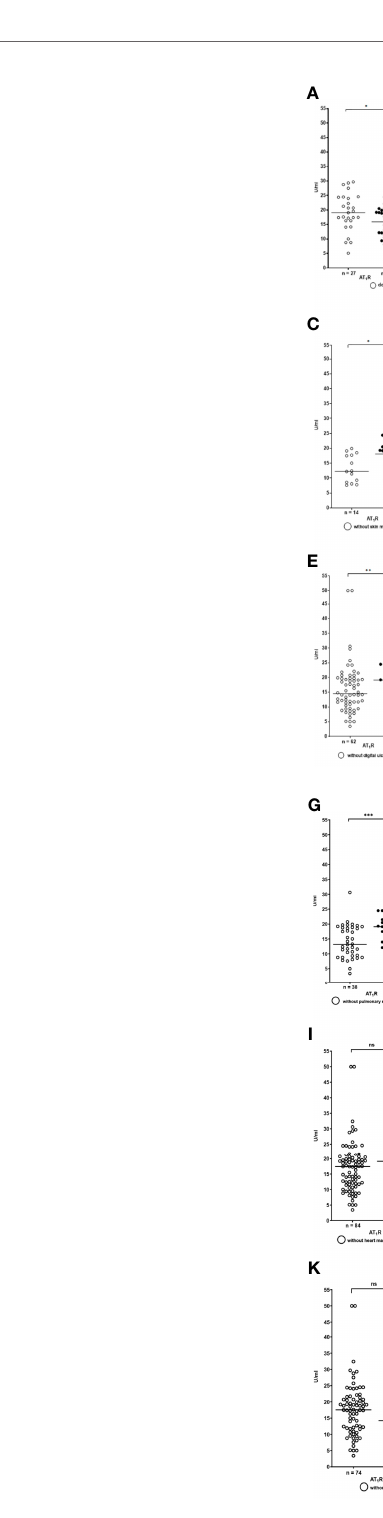
FIGURE 3 | Reactivity of antibodies to AT 1 R, ET A 1, and topo-I measured by ELISA in SSc patients comparing patients with lcSSc and dcSSc (A) , patients with different numbers of organ manifestations (B) , patients with and without skin manifestations (C) , calcinosis (D) , digital ulcers (E) , myositis (F) , lung manifestations (G) , pulmonary arterial hypertension (PAH) (H) , heart manifestation (I) esophageal manifestation (J) , and sicca-syndrome (K) . Individual values are given. Anti-topo-I abs refer to the left, anti-AT 1 R- and – ET A R-abs to the right y-axes. - median. n.s., not signi fi cant; *p < 0.05; **p < 0.01; ***p <